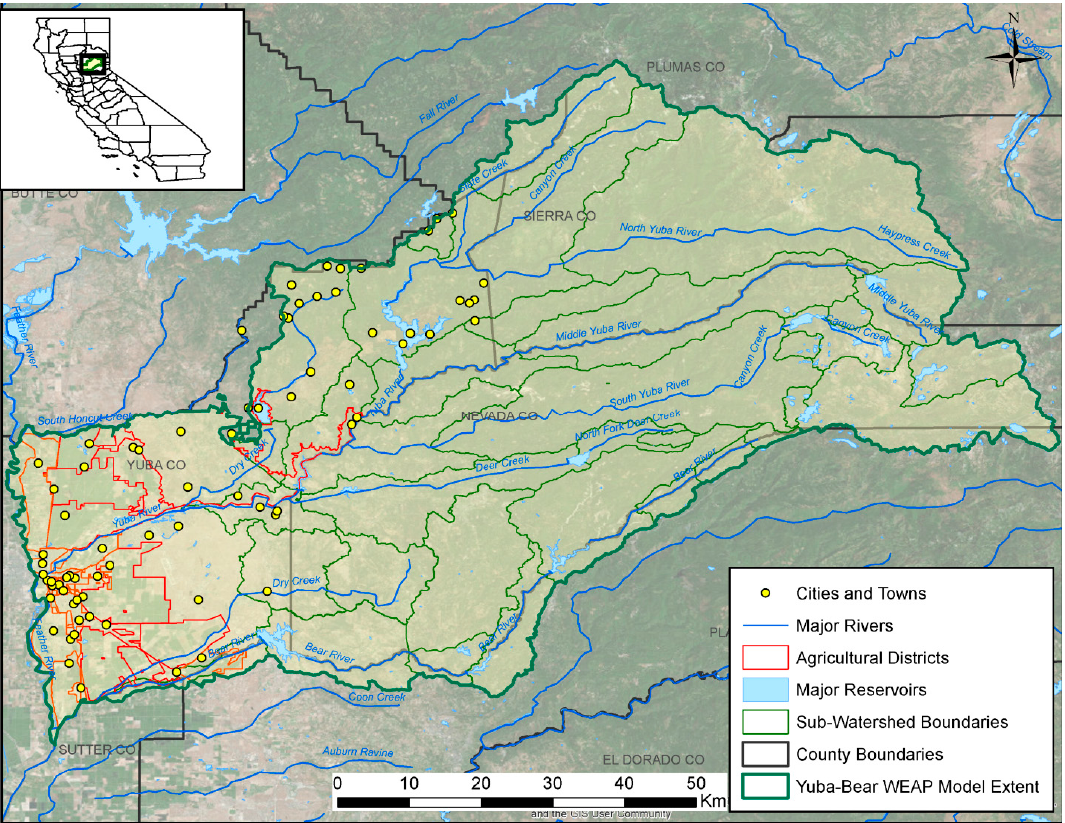
Figure 5. The Yuba River Watershed in Northern California, depicting the source water region in the Sierra Nevada as well as the water management infrastructure located within Yuba County in the western portion of the watershed. Red dashed lines show the position of irrigation districts with access to some portion of the flow in the Yuba River Watershed, yellow dots show the location of population centers where drinking water is supplied by a public utility. (Data source: California Spatial Information Library).